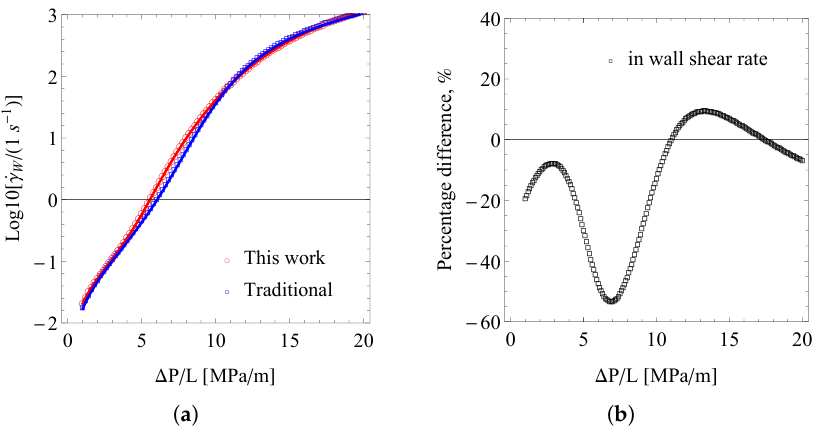
Figure 9. Wall shear rate ( a ) and the percentage difference ( b ) on the predicted wall shear rate. Tube radius R =